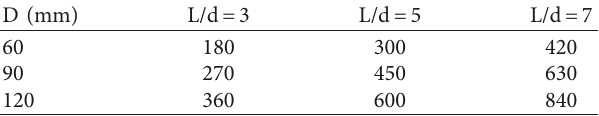
Figure 3: Geometric arrangement of stone columns studied in the present study. Table 1: The length of the stone columns studied in the present study.